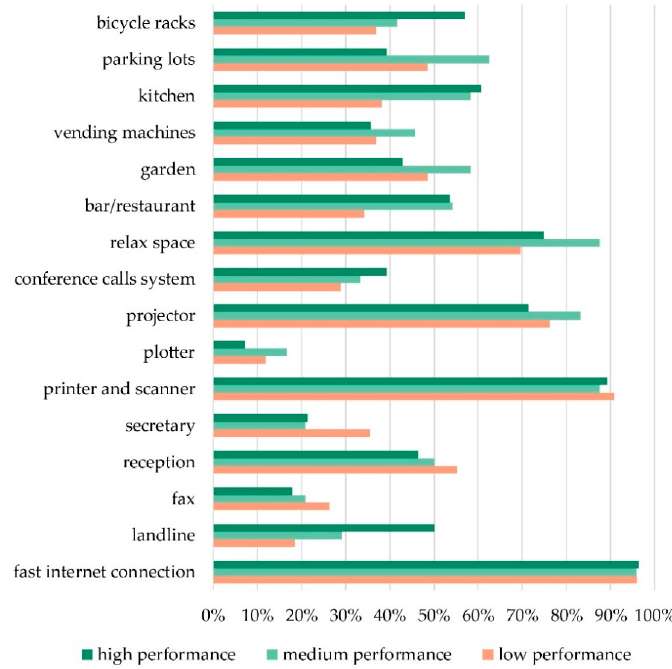
Figure 14. Services offered by performance category (percentages calculated from the total number of answers received for each service).